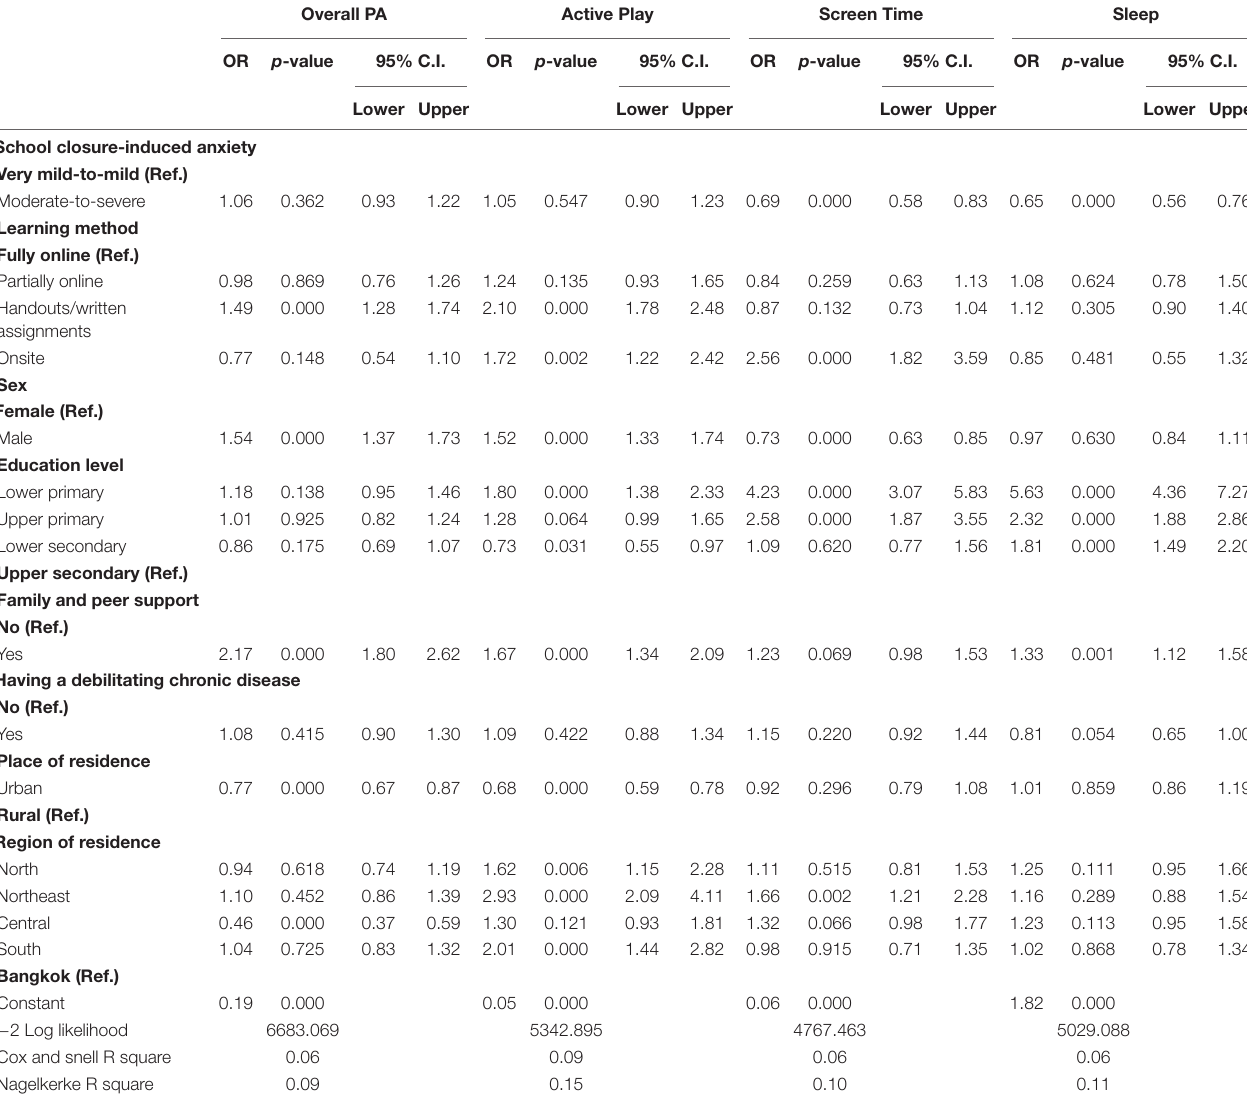
TABLE 6 | Correlates of physical activity, screen time and sleep during pandemic-related school closure. Overall PA Active Play Screen Time Sleep